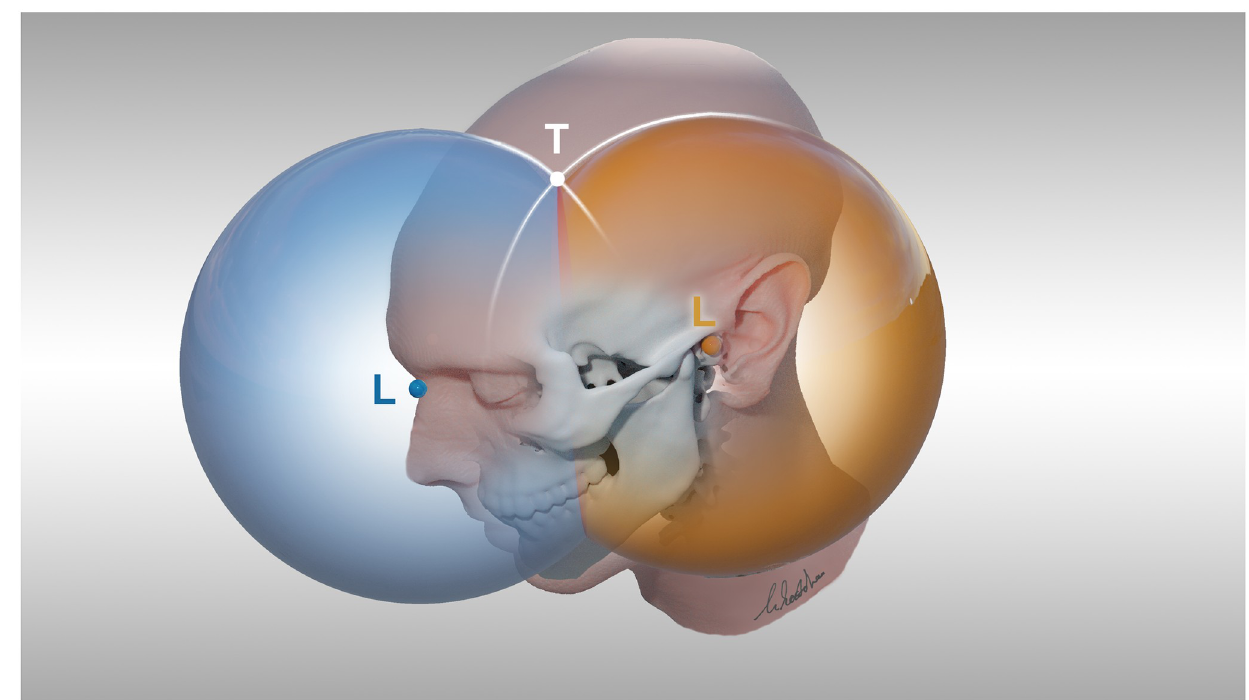
Fig 1. Scheme of the method. Yellow L Landmark Porus acusticus externus, blue L Landmark Nasion, T Target.